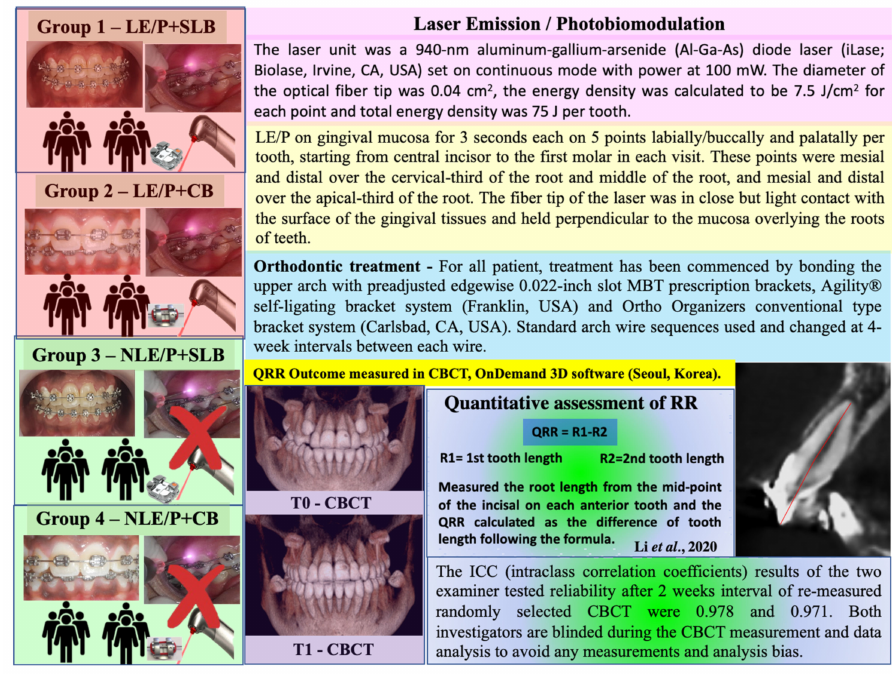
Figure 2. Details of photobiomodulation (LE/P) and quantitative assessment of RR. Statistical